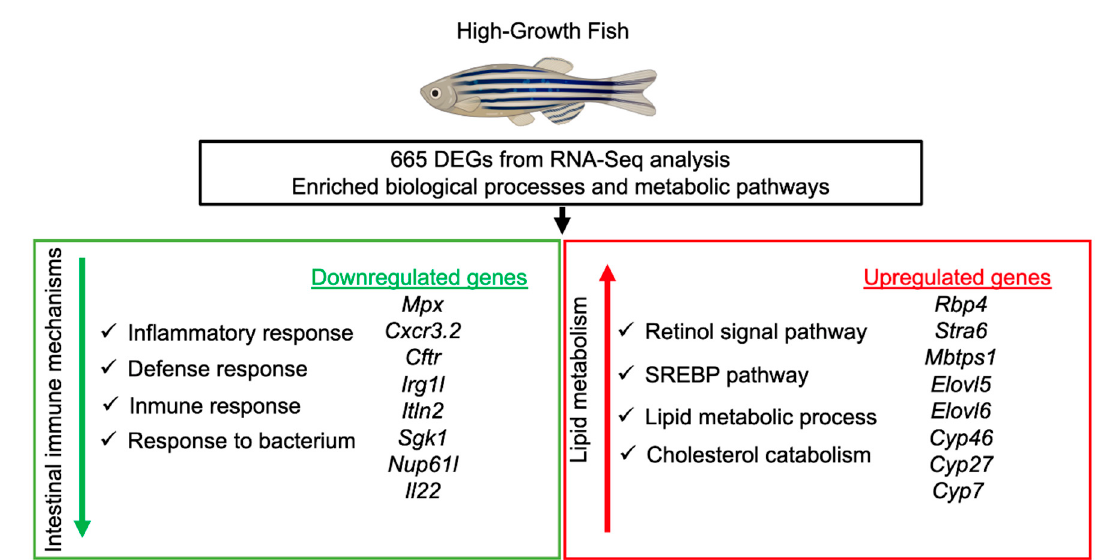
Figure 6. Genes and molecular mechanisms involved in intestinal tolerance to SBM-based diet in high-growth fish. Downregulation of genes associated with the inflammatory immune response and upregulation of genes related to lipid metabolism mediate SBM tolerance.